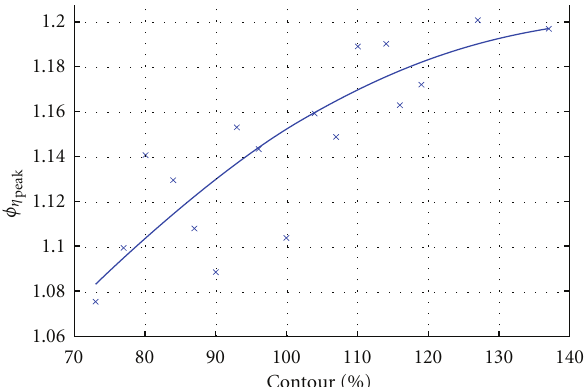
Figure 20: Head coe ffi cient at the surge as a function of the contour.